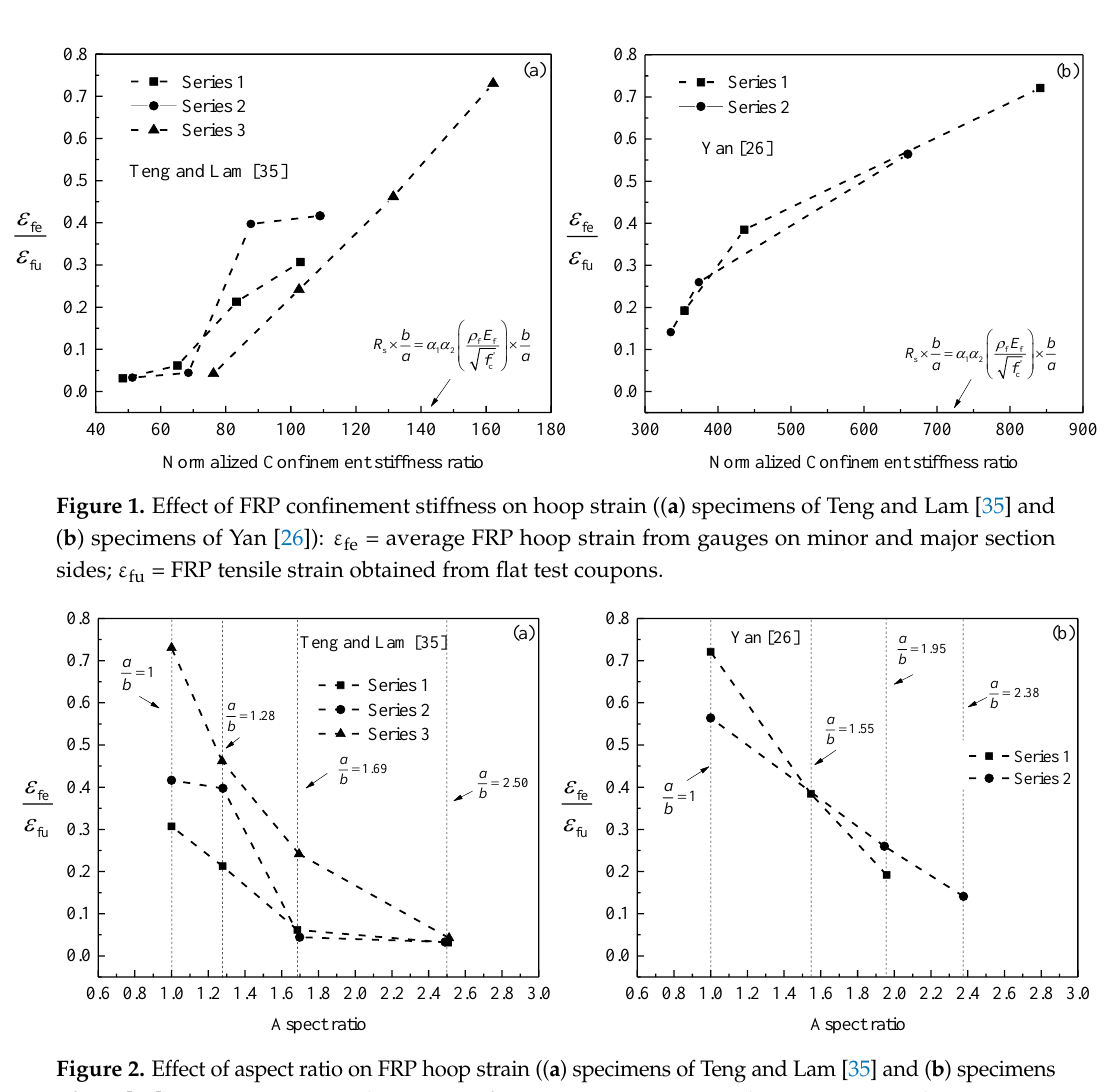
Figure 2. Effect of aspect ratio on FRP hoop strain (( a ) specimens of Teng and Lam [35] and ( b ) specimens of Yan [26]): ε fe = average FRP hoop strain from gauges on minor and major section sides; ε fu = FRP tensile strain obtained from flat test coupons.